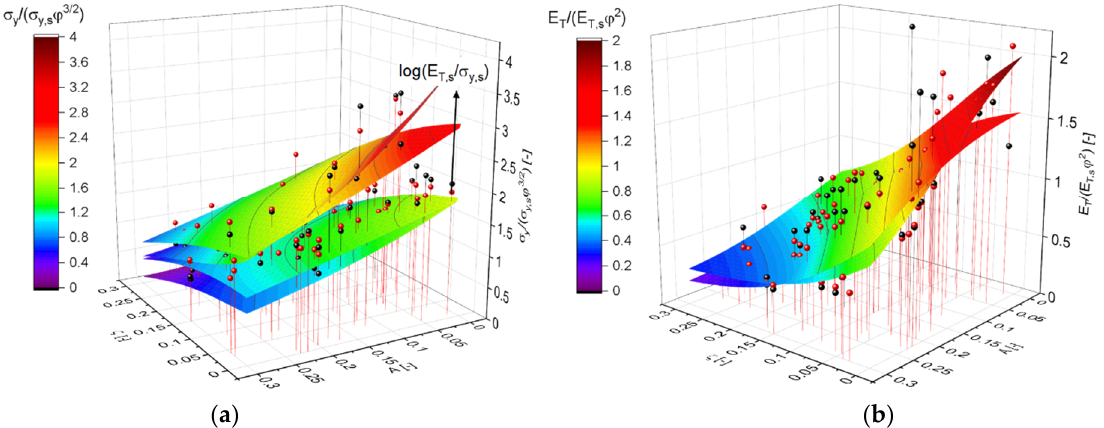
Figure 9. Visualization using MLP regression (shown as contour plot) along with black and red spheres corresponding to the data from ligament shapes G 21 and G 33 , respectively. ( a ) Scaled yield stress after Equation (14). Each pair of contour plots represents the two solid fractions. The parametrization of log ( E T , s / σ y , s ) corresponds to the values 0.5 and 2.5. ( b ) Scaled work hardening rate after Equation (15) with an exponent β = 2, where the inputs for the MLP regression are reduced to A and ζ . The pair of planes represent the two solid